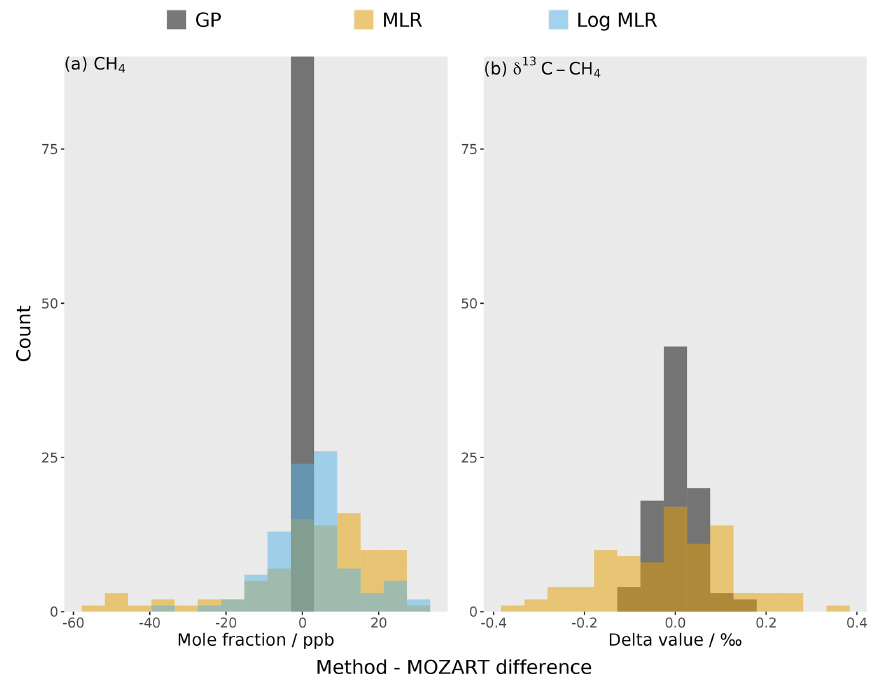
Figure 6. The residuals for the global mean between the different emulation methods (in different colours) and the true MOZART output for (a) methane mole fraction and (b) δ 13 C–CH 4 . Each emulator is built using a Gaussian process (GP) (grey) or multiple linear regression (MLR) (orange). The mole fraction has an additional emulator: a multiple linear regression with log-transformed OH